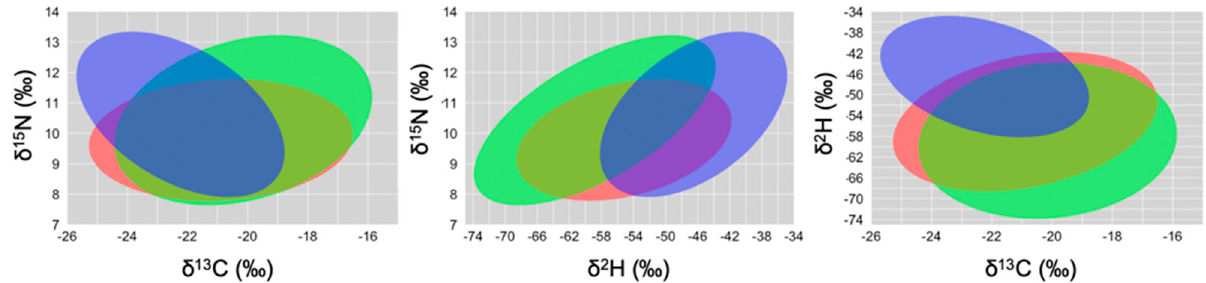
Figure 2. Two-dimensional graphs based on δ 13 C~ δ 15 N (left), δ 2 H~ δ 15 N (center) and δ 13 C~ δ 2 H (right), showing the isotopic niches of foraging guilds: granivorous finches (red; SGF and MGF), herbivorous finches (green/yellow; LGF, CF and VF), and insectivorous finches (blue; STF, GWF and WF). We followed the code proposed by Rossman et al. [33]. Table 4. Standard ellipse areas (SEA) and ellipse areas corrected for small sample size (SEA c ), and pairwise isotopic niche overlap between these foraging guilds.